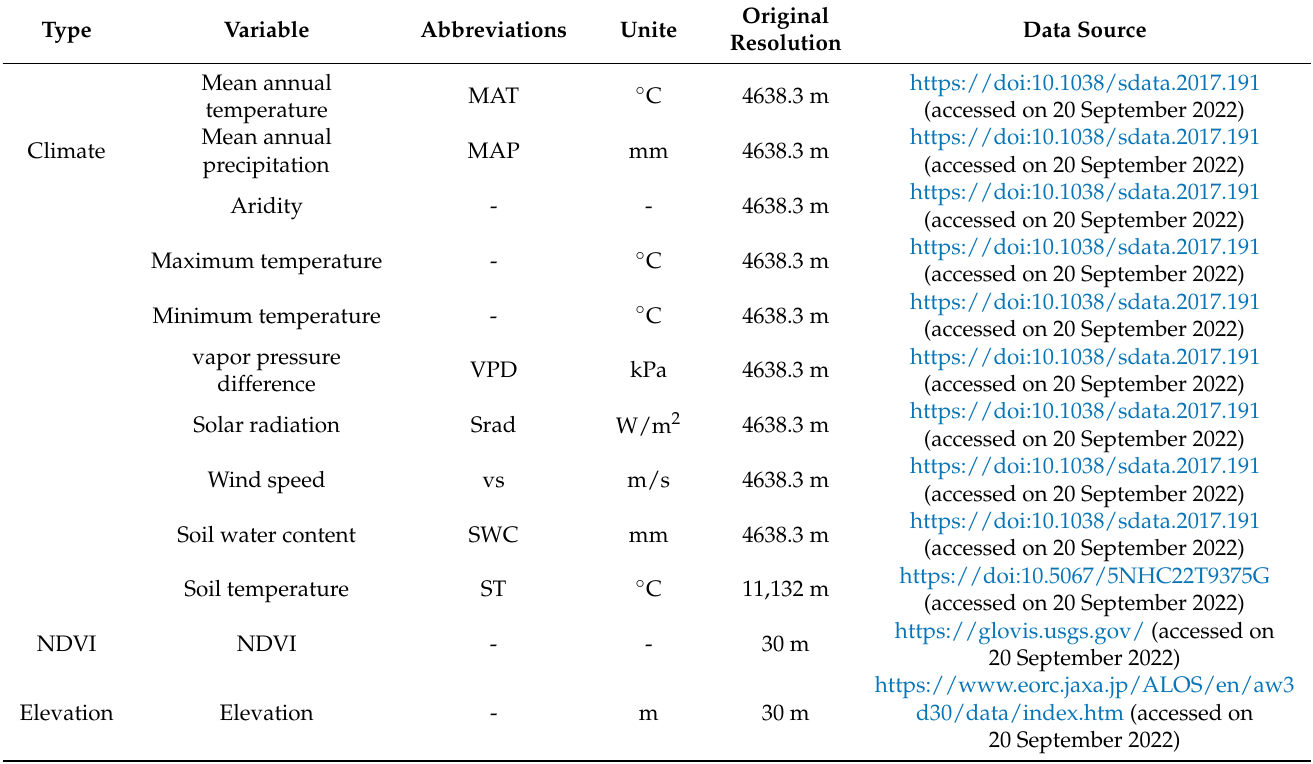
Table 2. Data sources and basic parameters.